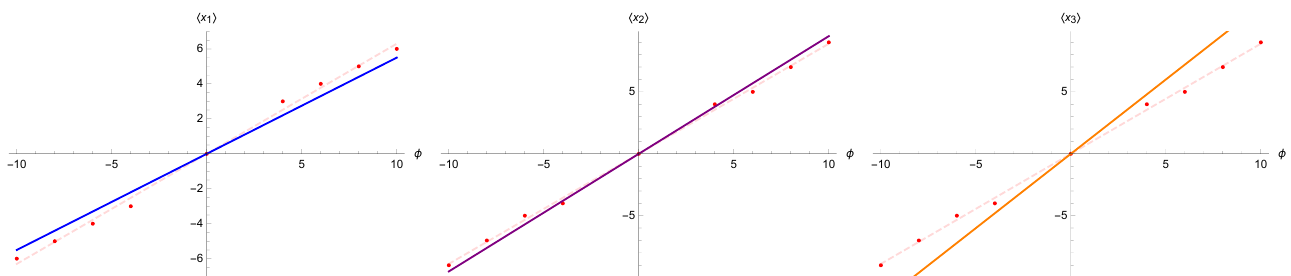
Figure 9. The three pictures show the position of the peaks of P ( x i , φ ) for i = 1,2,3 respectively in function of time φ (red dots). The resulting fitting functions (red dashed straight lines) overlap the semiclassical trajectories (continuous lines) with a confidence level of the order of 3 standard